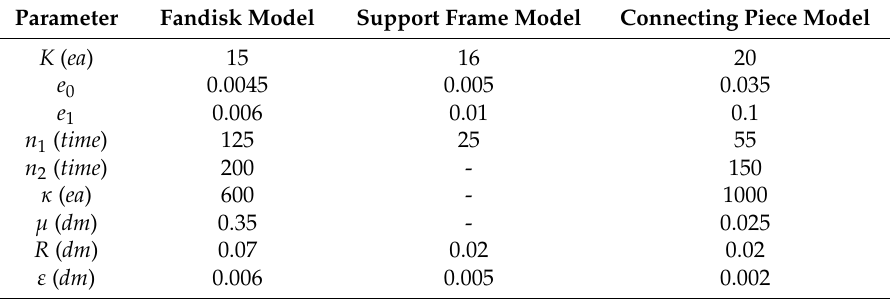
Table 3. Point cloud data of the three